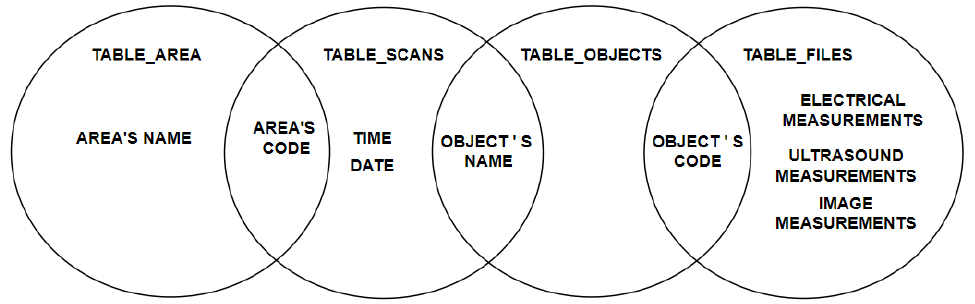
Figure 17. Data Structure of the developed Web-Platform.